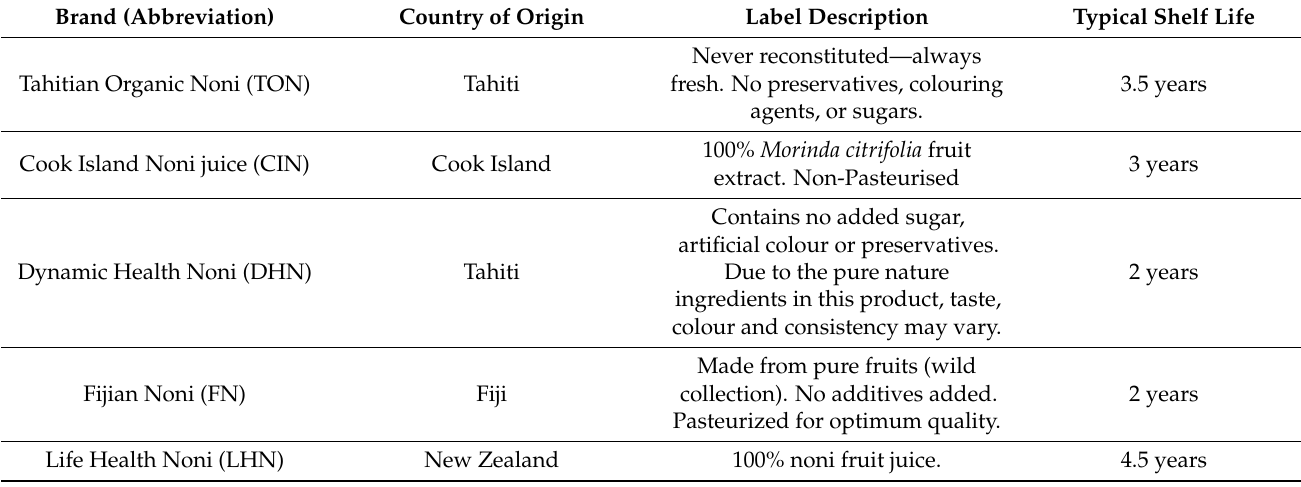
Table 1. Label descriptions of the noni juice samples included in this study.